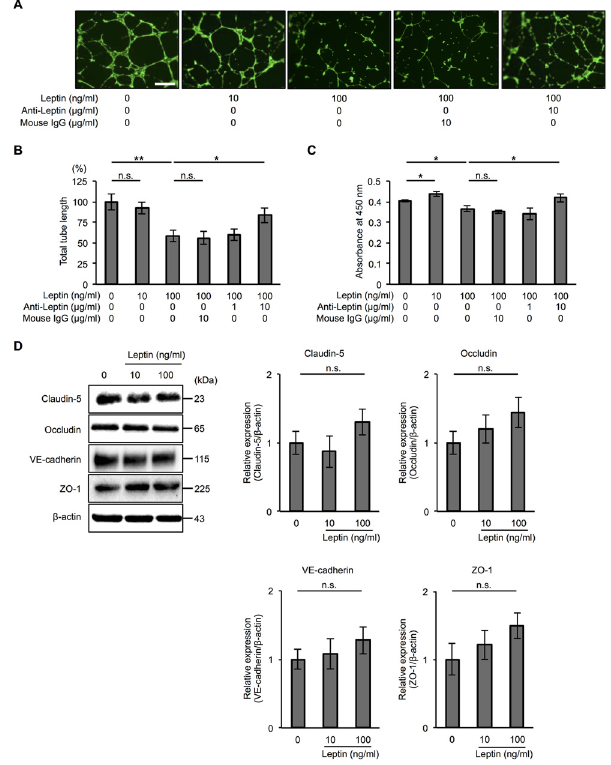
Fig 3. Effect of leptin on lymphatic endothelial cell tube formation and proliferation. ( A ) Representative phase contrast microscopy images showing tube formation in HDLECs treated with leptin (10, 100 ng/ml) for 17 h with or without anti-leptin antibody (10 μ g/ml). Scale bar: 50 μ m. ( B ) Histograms represent total tube length in HDLECs exposed to leptin (10, 100 ng/ml) for 17 h with or without 1 or 10 μ g/ml anti-leptin antibody. Total tube length and mean length in each condition were measured using Image J software. Results are expressed as means ± SEM of four independent experiments; * p < 0.05, ** p < 0.01, t -test. n.s.: not significant. ( C ) WST-8 assay showing proliferation of HDLECs treated with leptin (10, 100 ng/ml) for 17 h with or without 1 or 10 μ g/ml anti-leptin antibody. Histograms represent absorbance at 450 nm. Results are expressed as means ± SEM of four independent experiments; * p < 0.05, t -test. n.s.: not significant. ( A-C ) Anti-leptin antibody was added 30 min prior to leptin treatment. Ten μ g/ml mouse IgG was used as an isotype control to anti-leptin antibody. ( D ) Immunoblot analysis showing the expression of claudin-5, occludin, VE- cadherin, and ZO-1 in HDLECs treated with leptin (10, 100 ng/ml) for 24 h. β -actin was used as a loading control. Histograms represent relative expression of claudin-5, occludin, VE-cadherin, and ZO-1 proteins in HDLECs exposed to 10 or 100 ng/ml leptin for 24 h as determined by densitometry analysis. Results are expressed as means ± SEM of four independent experiments; t -test. n.s.: not